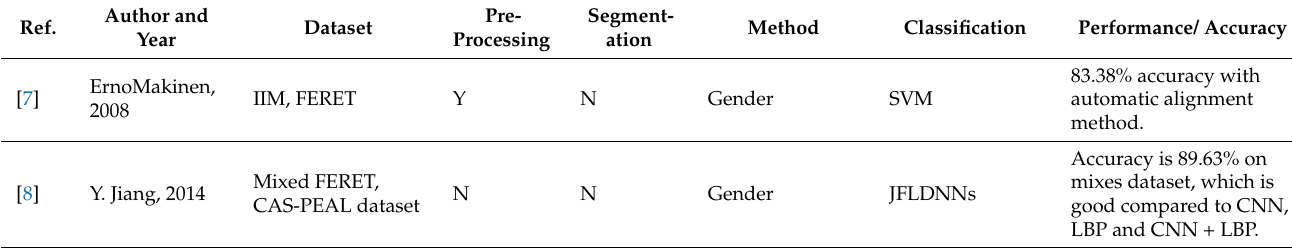
Table 1. Literature work on existing